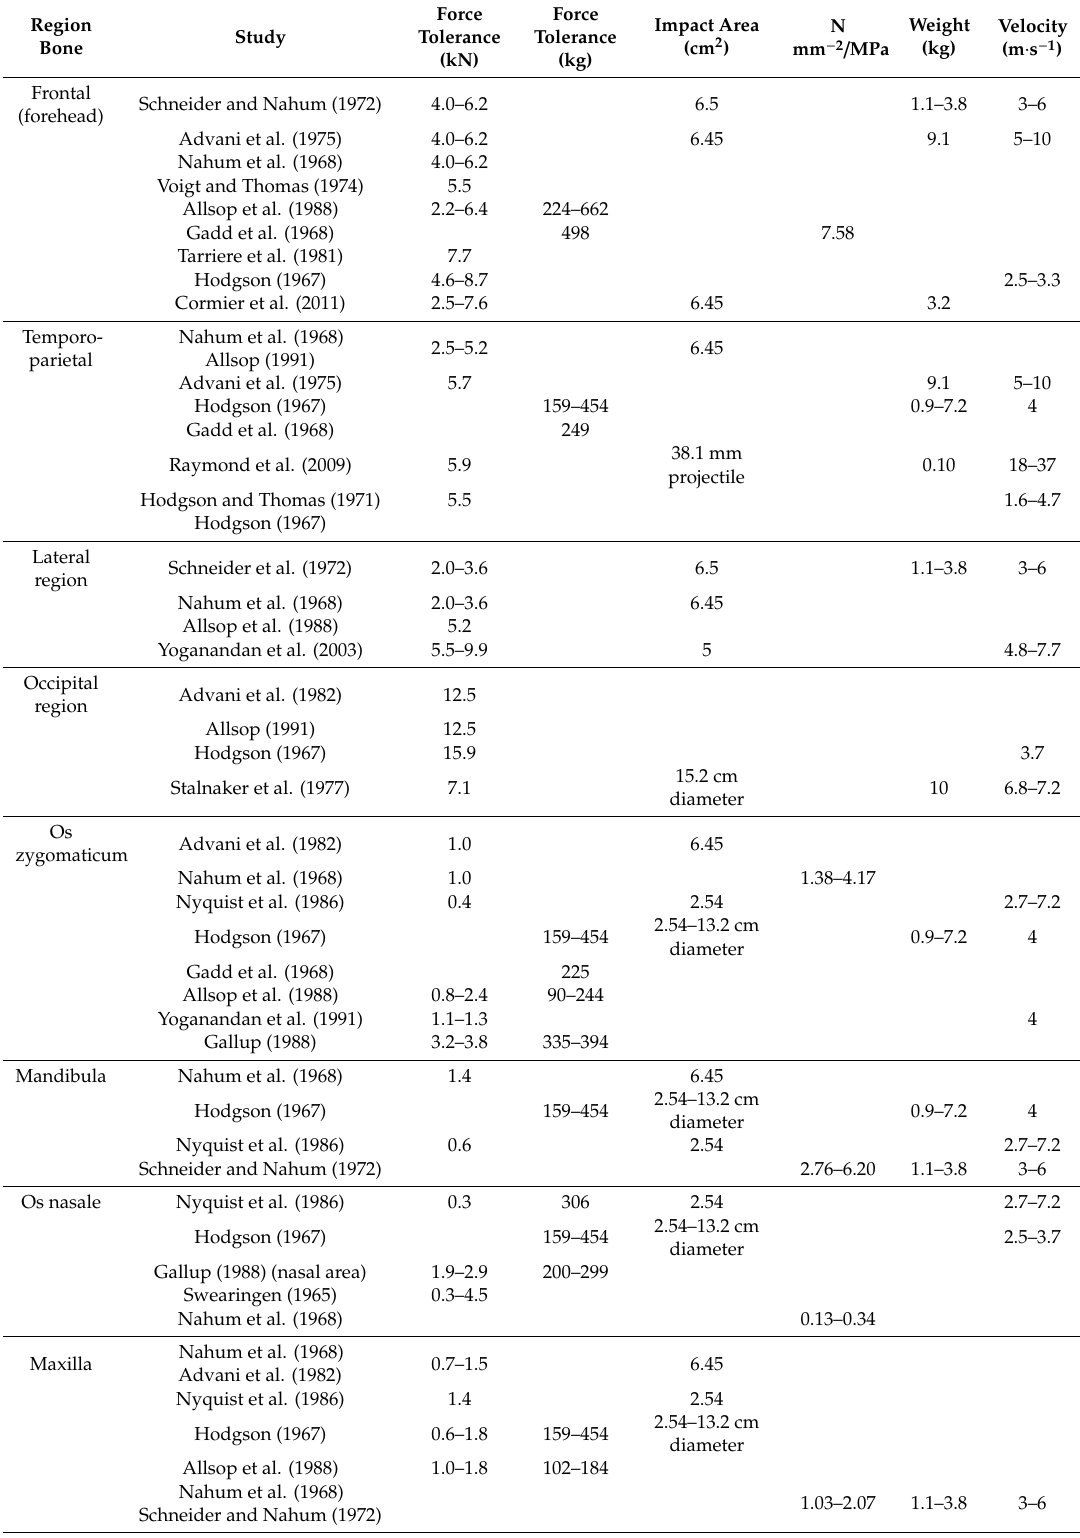
Table A1. Biomechanical tolerance of di ff erent regions / bones of the skull—contact force required for